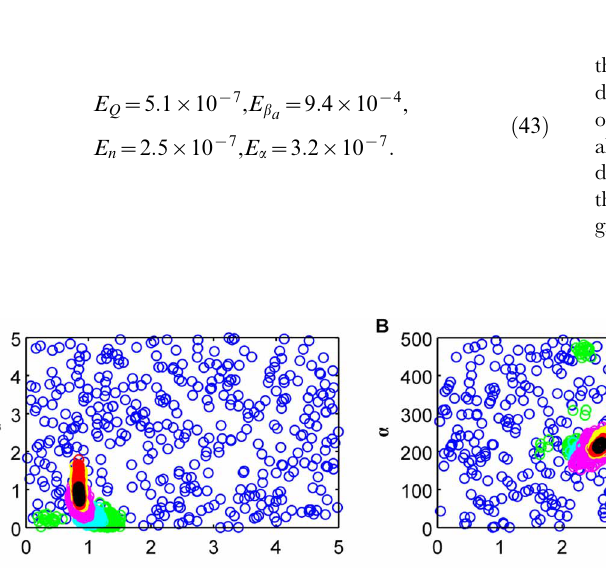
Figure 5. Histograms of the approximate marginal posterior distributions for each parameter for the ABC SMC algorithm when considering E ~ 0 : 0001 . (A) Q , (B) b a , (C ) n and (D) a .